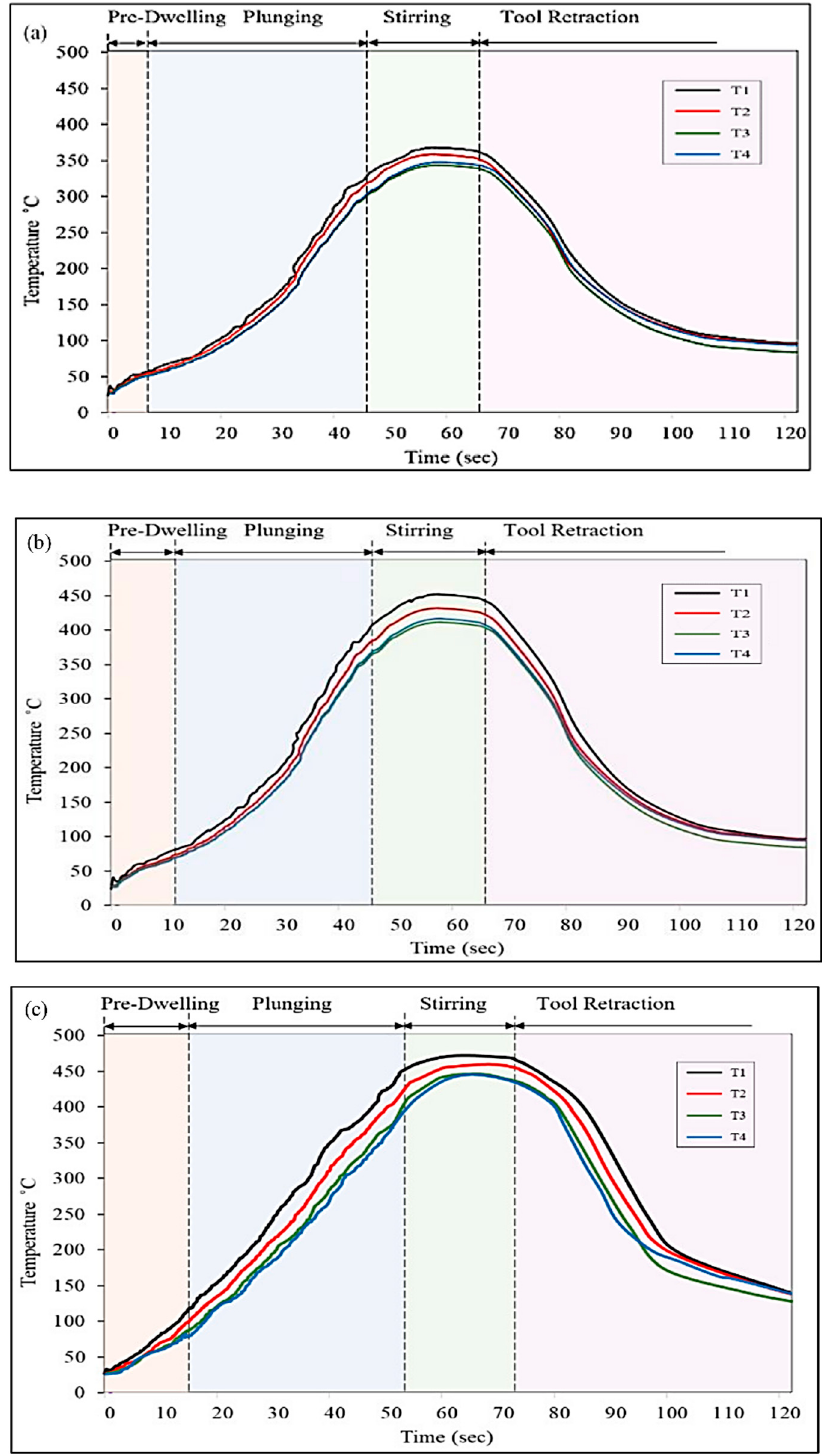
Figure 5. Temperature profile of the FSSW welds obtained at ( a ) 2.5 mm guiding hole diameter, 1300 rpm tool rotation speed, and 6 s of pre-dwelling time; ( b ) 3.5 mm guiding hole diameter, 1300 rpm tool rotation speed, and 14 s of pre-dwelling time; and ( c ) 3.5 mm guiding hole diameter, 2100 rpm tool rotation speed, and 10 s of pre-dwelling time .